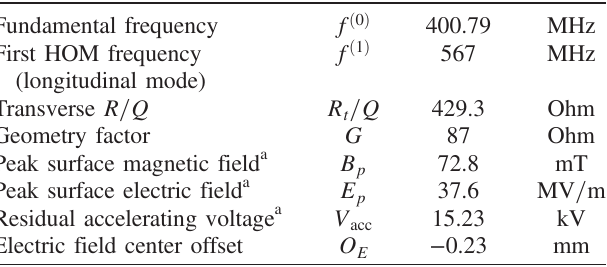
TABLE II. Electromagnetic properties of the SPS-series DQW cavity.